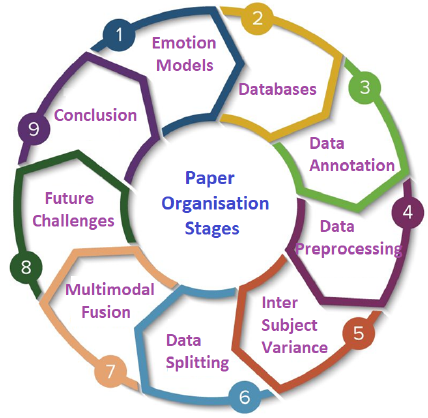
Figure 1. Paper organisation